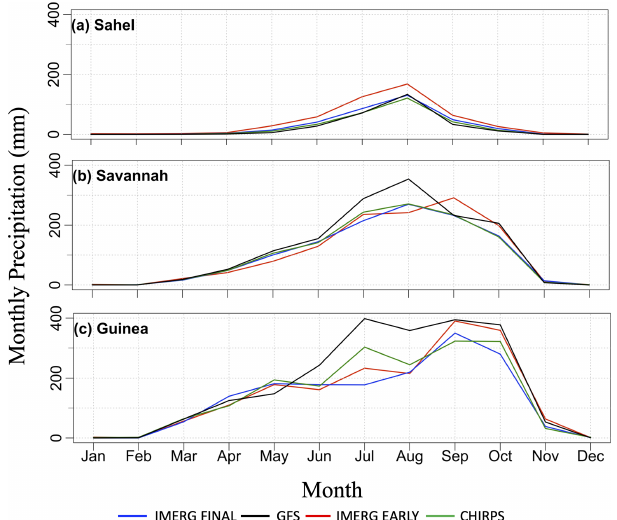
Figure 3. Monthly precipitation regime for the three climatolog- ical zones of the Niger river basin. (a) Sahel, (b) Savanna, and (c) Guinea. Analyses are based on rainfall fields derived from IMERG Final, GFS (1d lead time), IMERG Early, and CHIRPS. The time period covers 15 June 2019 to 15 June 2020.